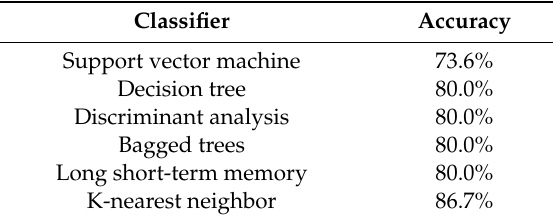
Table 1. Comparison of testing performance.